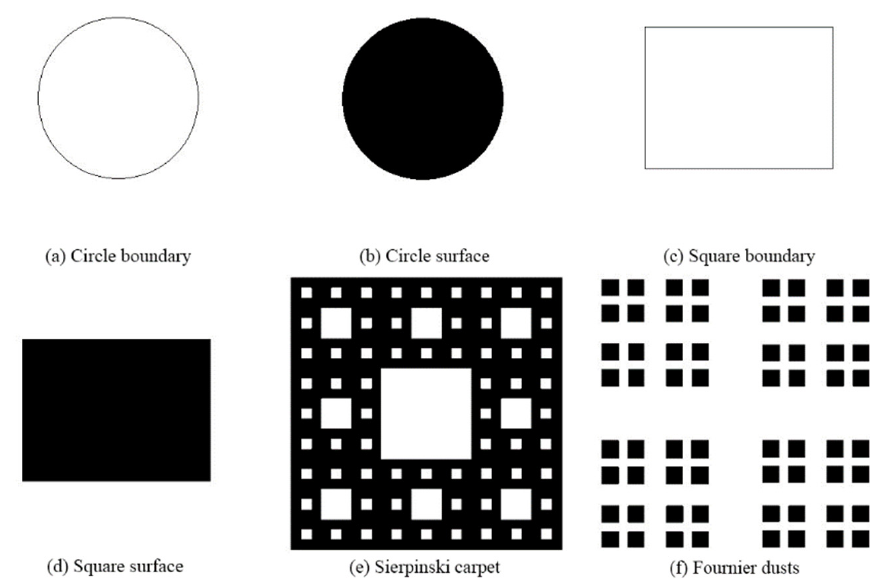
Figure 6. Six experimental patterns. Table 2. Comparison between theoretical fractal dimensions and experimental values in Frac- talyse.